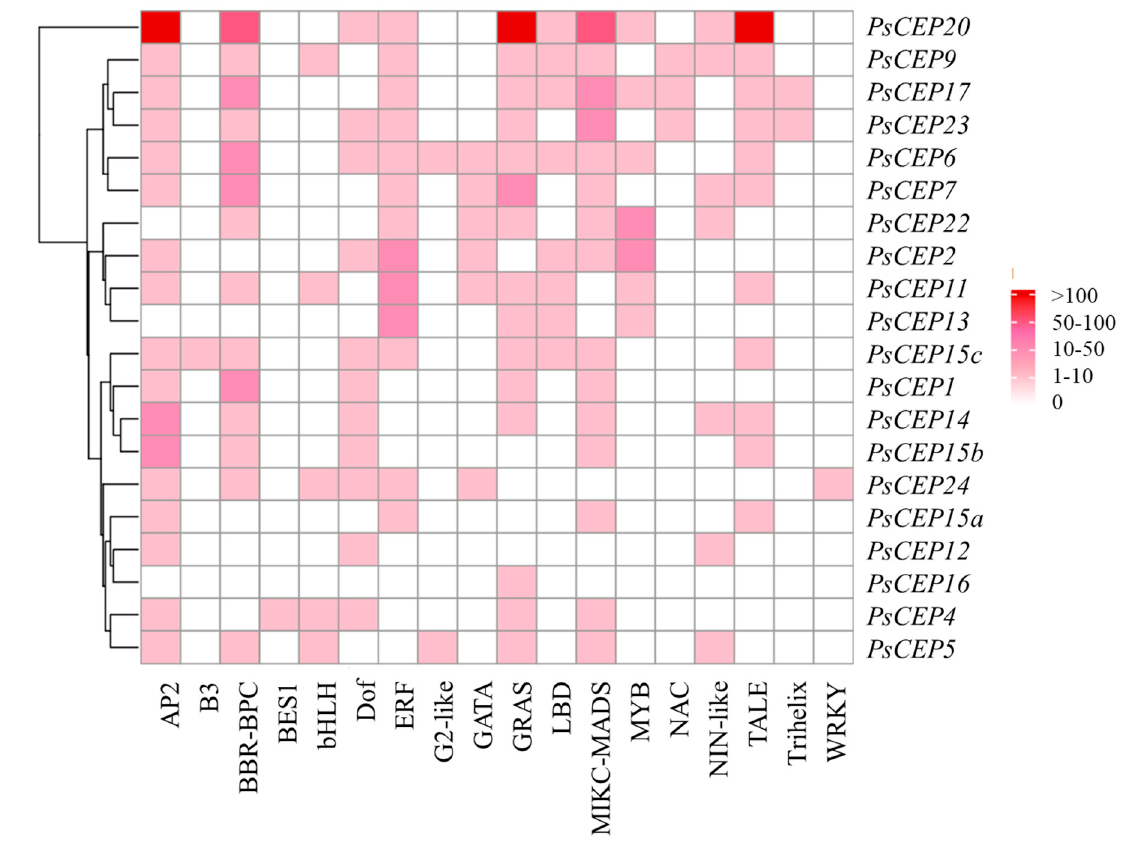
Figure 7. Cis–acting elements found in the promoters of the PsCEP genes. The color scale bar indicates the numbers of cis-acting elements in the promoters.